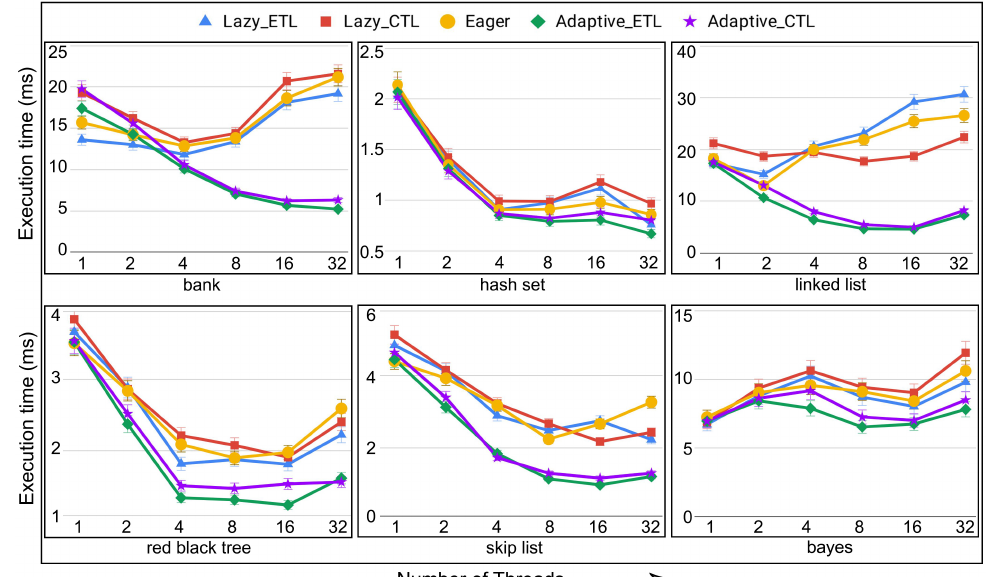
Figure 19. Execution time in micro-benchmarks and bayes from STAMP using better time barrier in non-persistent